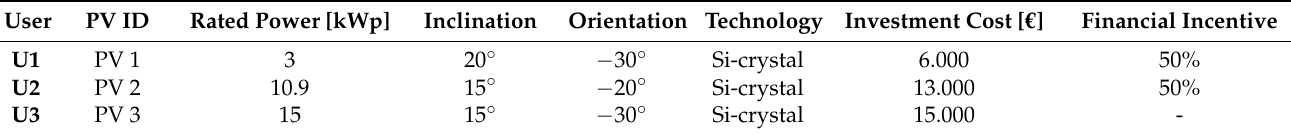
Table 4. Technical and economic characteristics of the community generators.